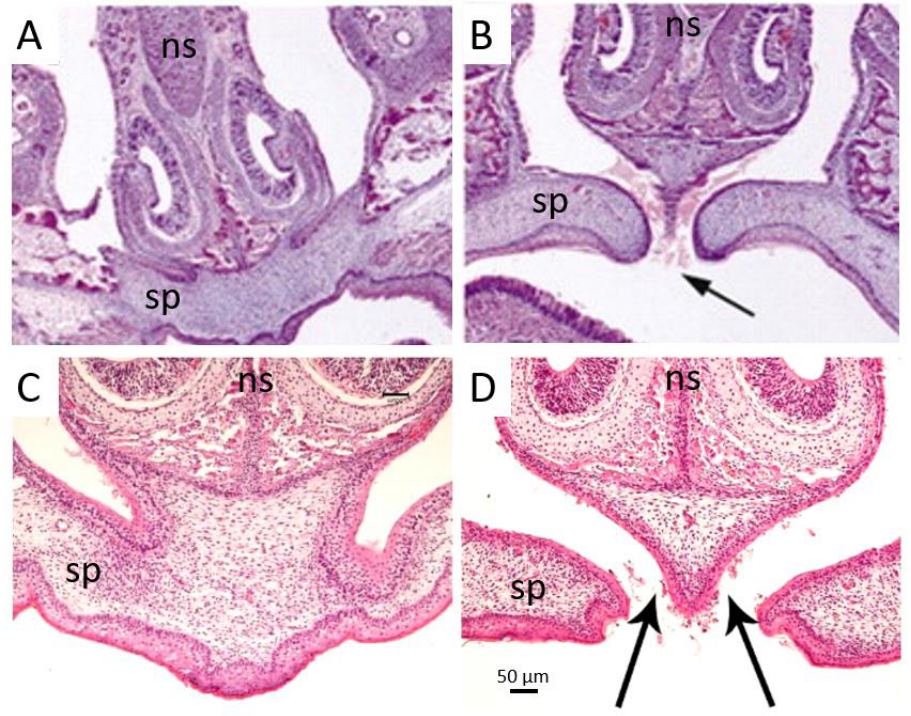
Figure 2. The palatal phenotypes of FGFR2 S252W and P253R Apert mouse models. ( A , B ) Incomplete closure of the anterior Fgfr2 +/2S252W secondary palate at P1 ( B ) compared to WT ( A ) (adapted from [84] and used with permission from Development: dev.biologists.org). ( C , D ) Incomplete closure of the anterior Fgfr2 +/P253R secondary palate at P0 ( D ) compared to WT ( C ) (adapted from [85]). ns, nasal septum; sp, secondary palate. Arrows indicate incomplete fusion. Similar to Fgfr2 +/S252W mice, Fgfr2 +/P253R mice exhibited incomplete fusion at the junction